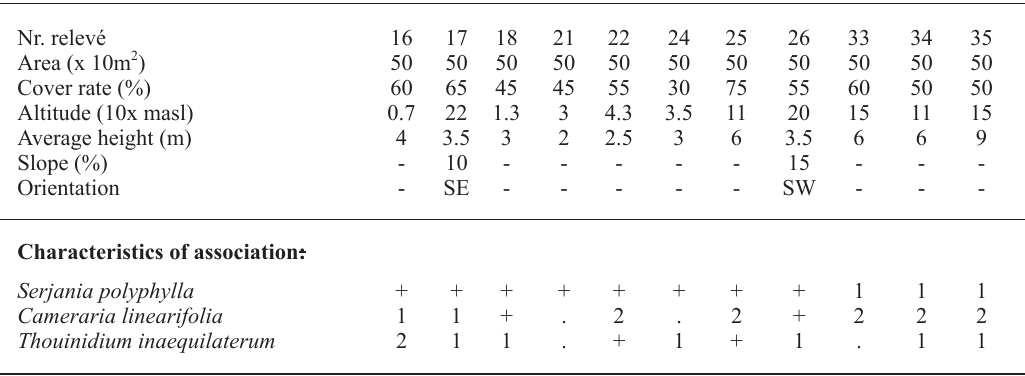
Consoleo moniliformis-Camerarietum linearifoliae ass.